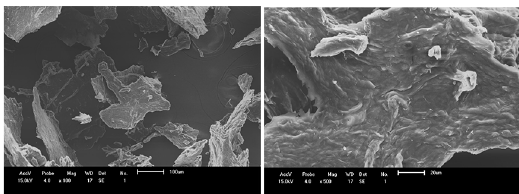
Fgure 11: SEM images of Cotton nanolinter particles. (Scale bar: 100 μm and 20 μm).